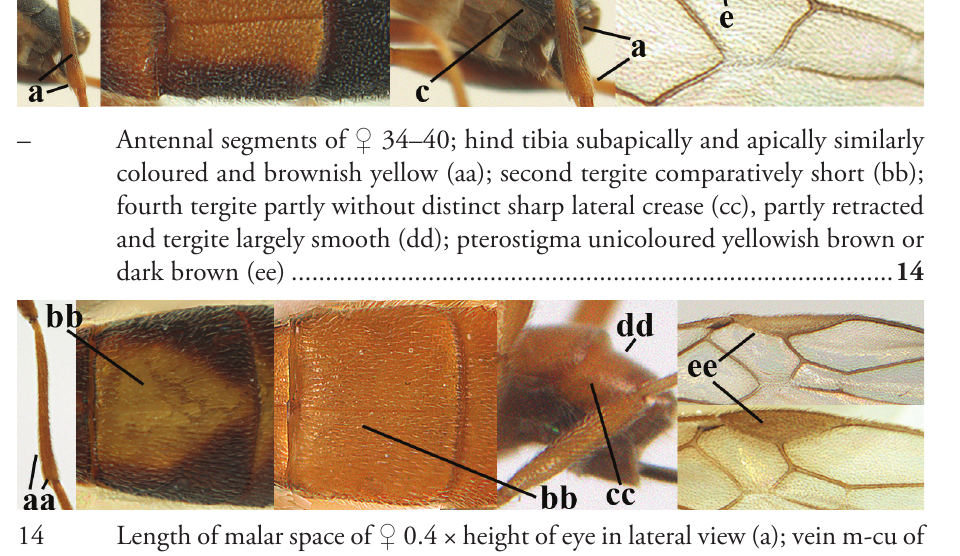
14 Length of malar space of ♀ 0.4 × height of eye in lateral view (a); vein m-cu of fore wing slightly curved towards vein 2-CU1, meeting it at about 140° (b); pterostigma dark brown (c); fore wing distinctly infuscate (d); inner side of hind tibia without apical comb (e); speculum sculptured (f); occipital carina complete or narrowly interrupted dorsally (g) ........... A. angustipterus sp. n.